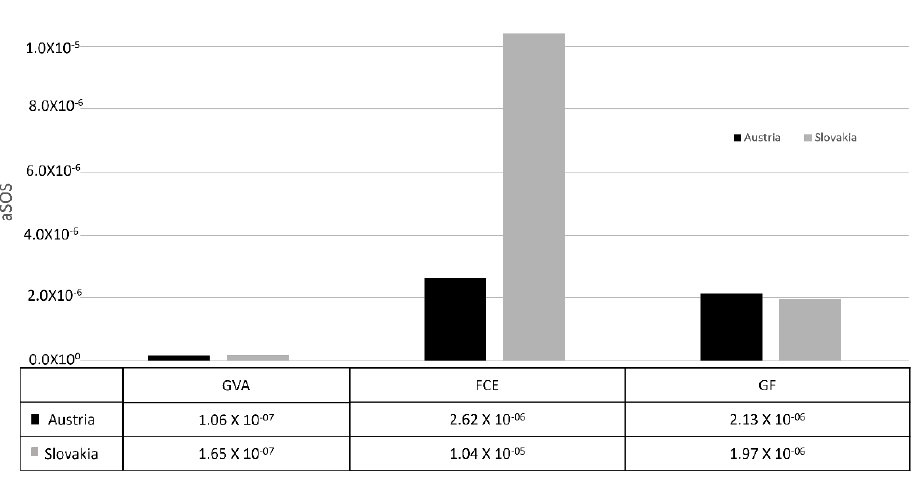
Figure 2. aSOS at an industry level using three different downscaling methods.